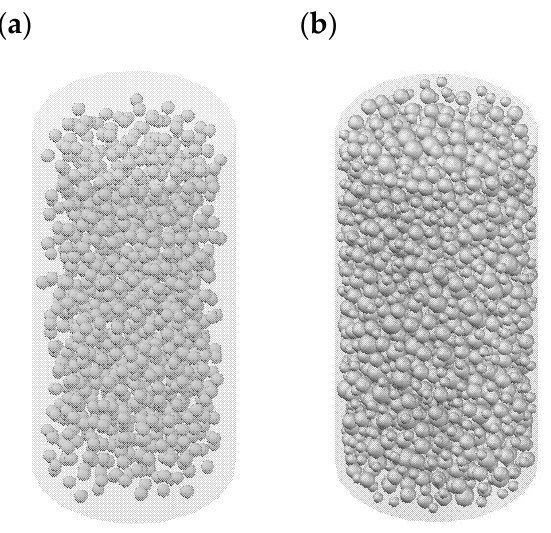
Figure 1. Concrete meso-structure: ( a ) 10% of coarse aggregate with one diameter (D = 10 mm) and ( b ) 30% of coarse aggregate with three diameters (10, 7.5 , 5